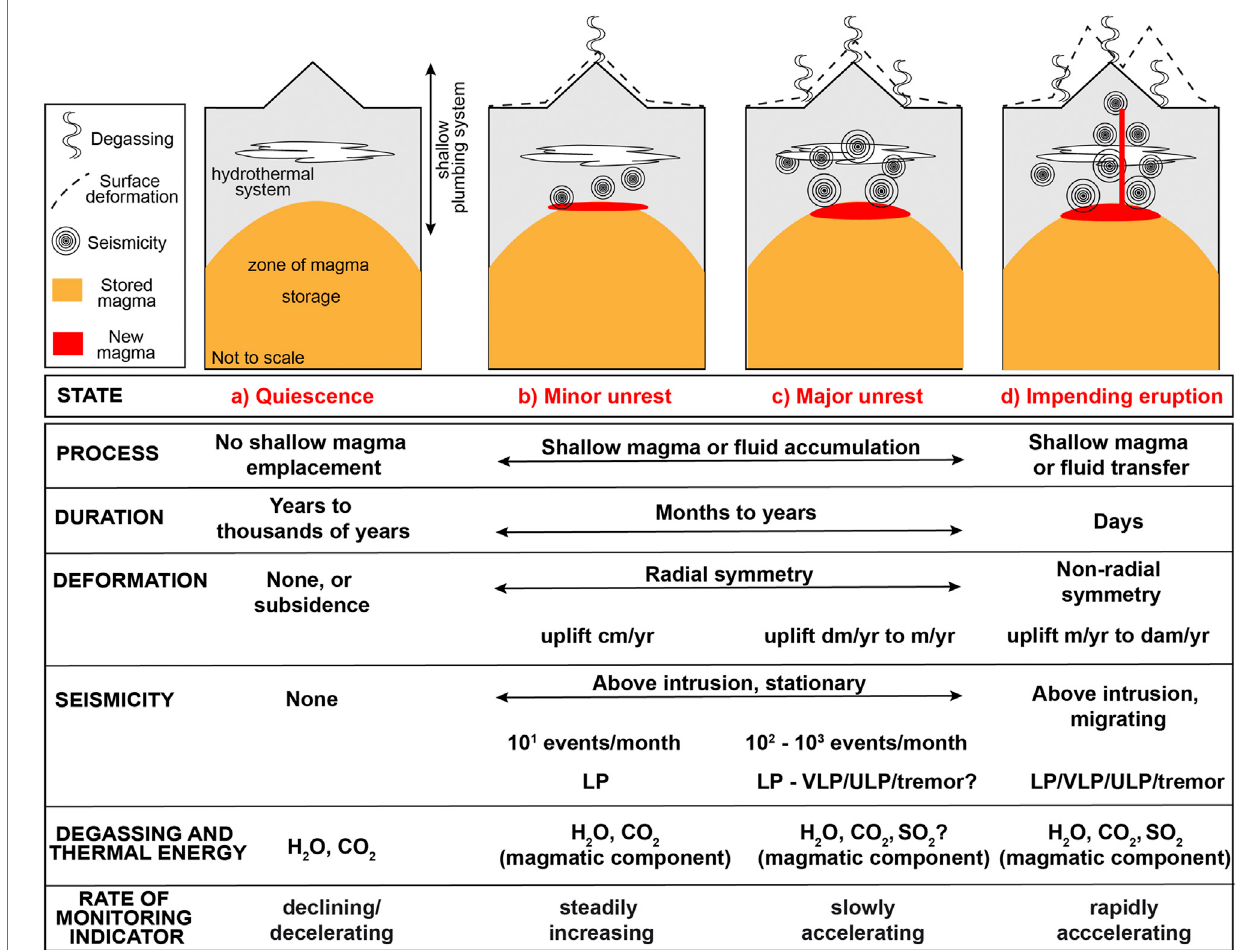
FIGURE1| Summaryofthefourmain statesofavolcano,and associated features.New magma=newly emplacedmagmaresponsibleforunrest;storedmagma = residual magma in the magmatic system, associated with the quiescent state of the volcano.